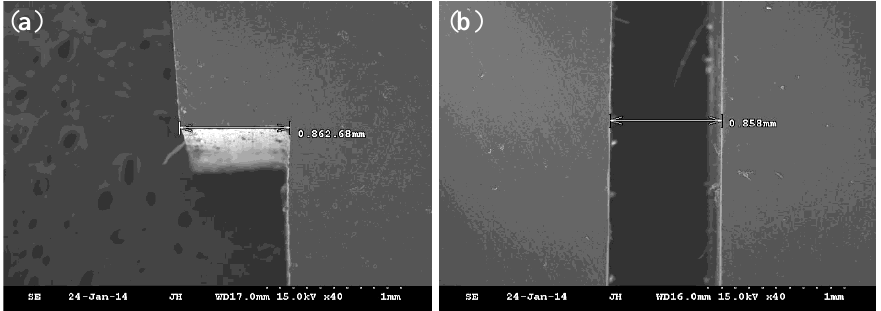
Figure 11. Cross-section images of the channel before bonding ( a ) and the channel at a bonding temperature of 35 °C ( b ).